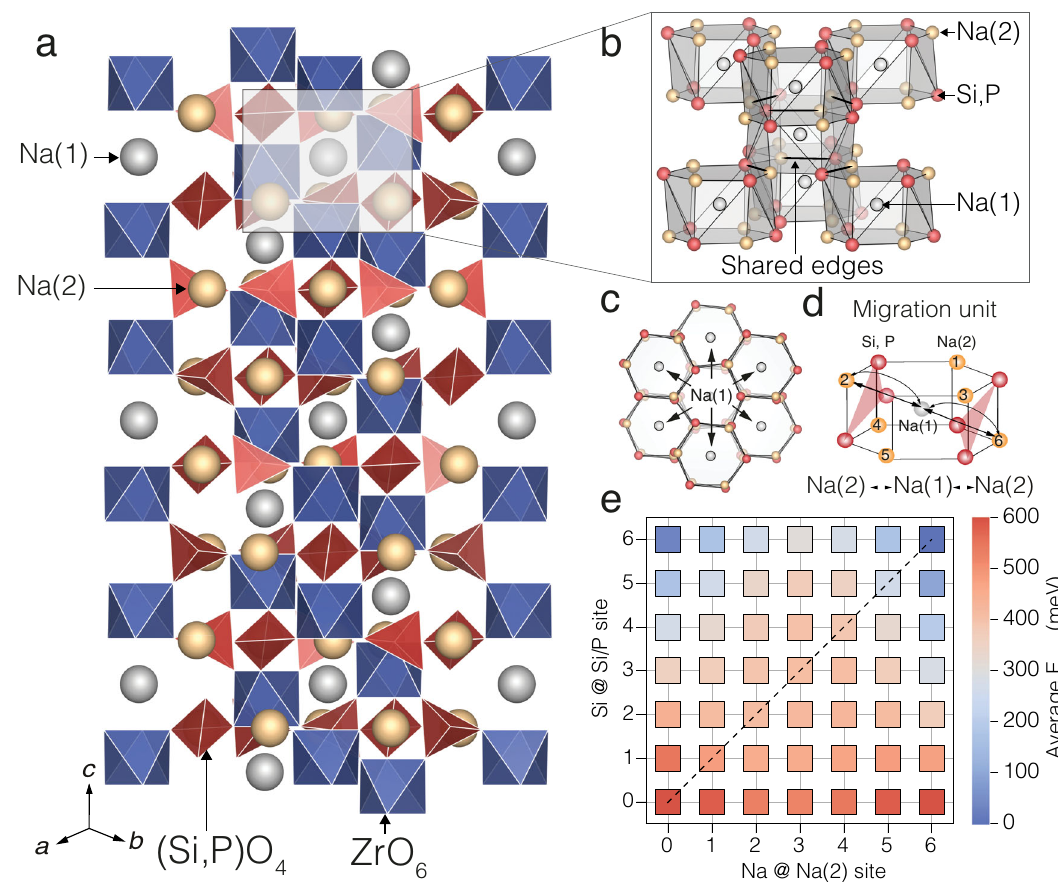
Fig.1|Characteristicsofsodium-iontransportinNASICON. Structuralmodelsof Na 1+ x Zr 2 Si x P 3 − x O 12 ( a – d ) and Na-ion migration barriers ( e ). In ( a – d ), the Na(1) sites areindicatedbysilverspheres,theNa(2)byorangespheres,the(Si/P)O 4 groupsby redtetrahedra,Si/Patomsbyredspheres,andZrO 6 unitsbyblueoctahedra.bandc depict the local environment of Na(1), with each Na(1) surrounded by six neigh- boring Na(2) atoms (orange spheres) and six Si/P (red spheres) atoms. For simpli- city,OandZratomsarenotshownin( b – d ).Eachsilverhexagonalprismin( b )or( c ) representsthe fi rst coordinationshellofaNa(1)site. Panel ( d )isthe migration unit used to study Na-ion migration in NASICON, and Na must hop across several